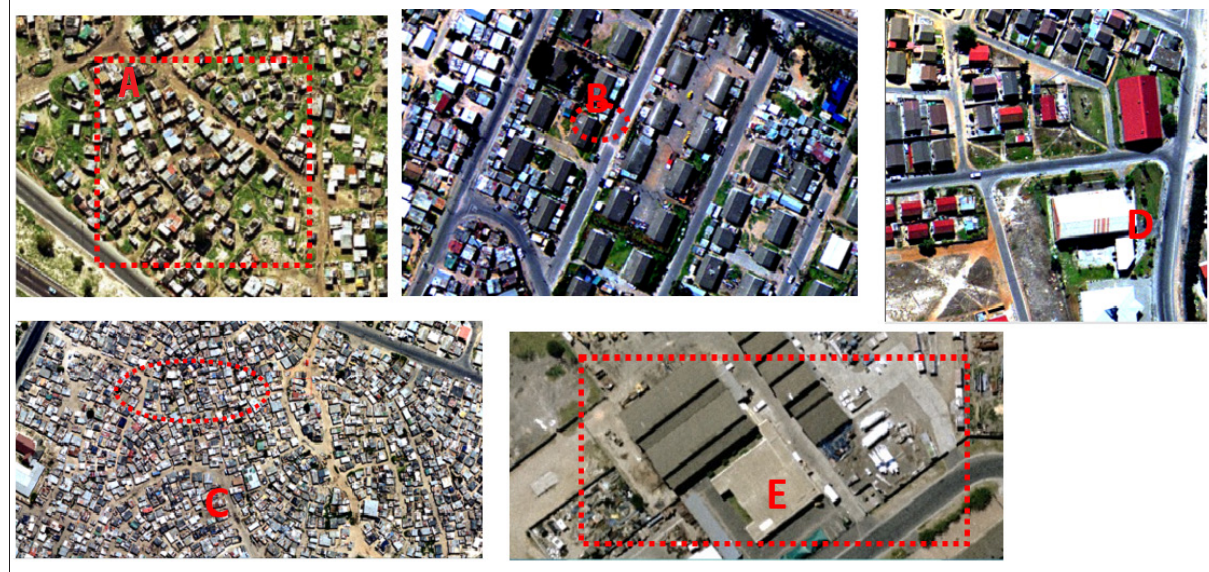
Figure 1: The five vertical aerial photographs of 250-mm resolution used for the feature identification